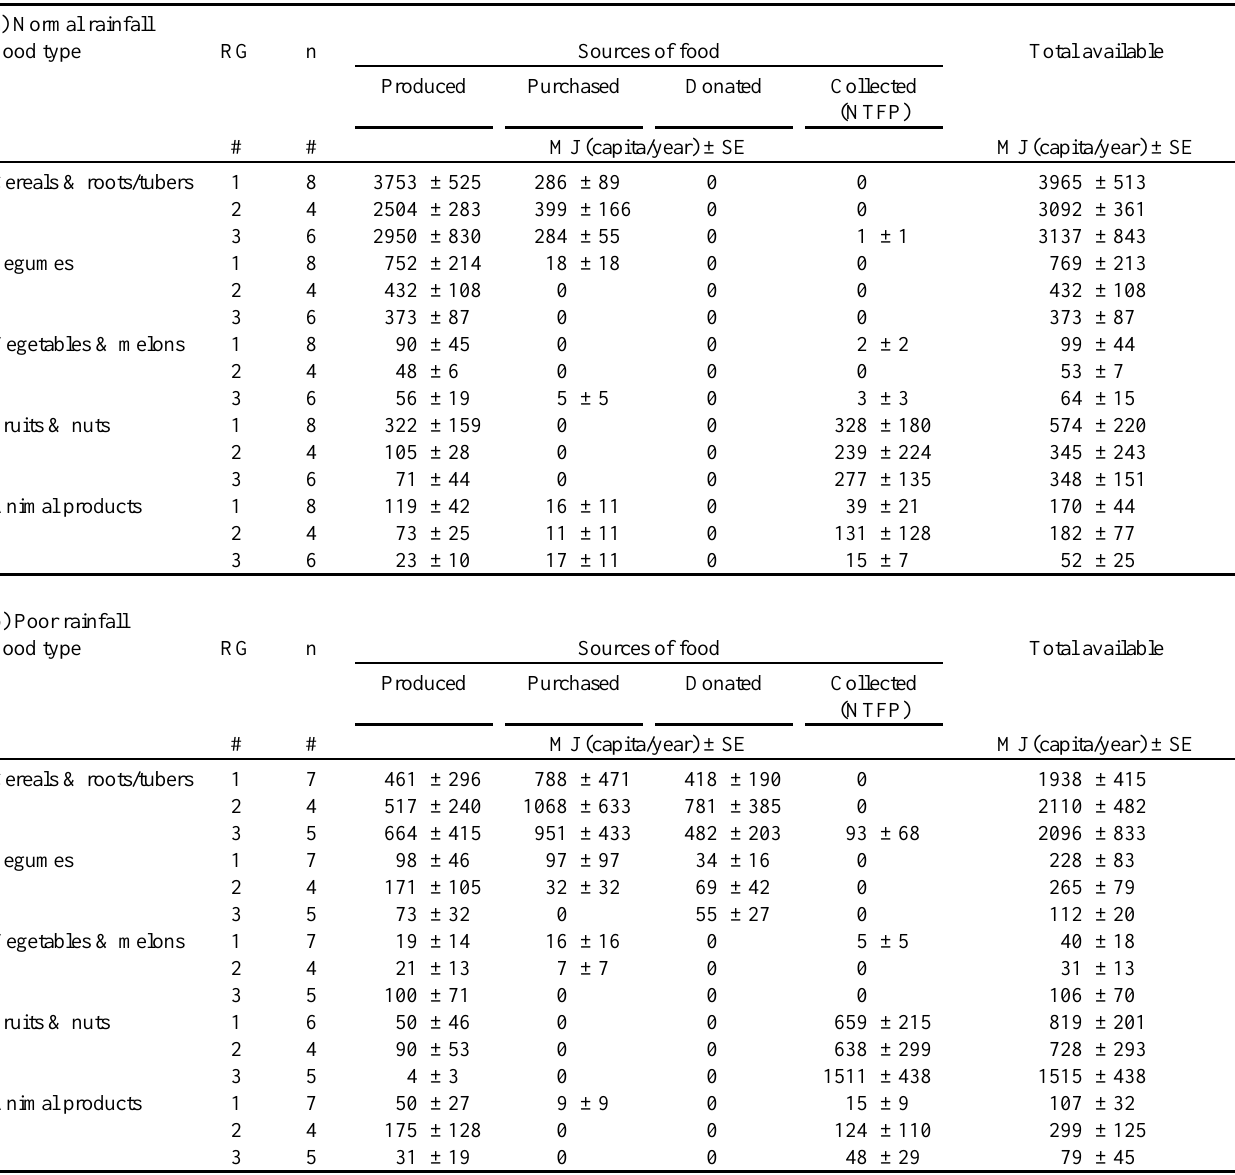
Table 4 . Mean contribution of different sources to the food energy availability for three resource groups (RG) in years of a) normal rainfall and b) poor rainfall. The cereals & roots/tubers category includes sunflower, the legumes category includes soya and groundnut, and the vegetables & melons category includes mushrooms. NTFP = nontimber forest